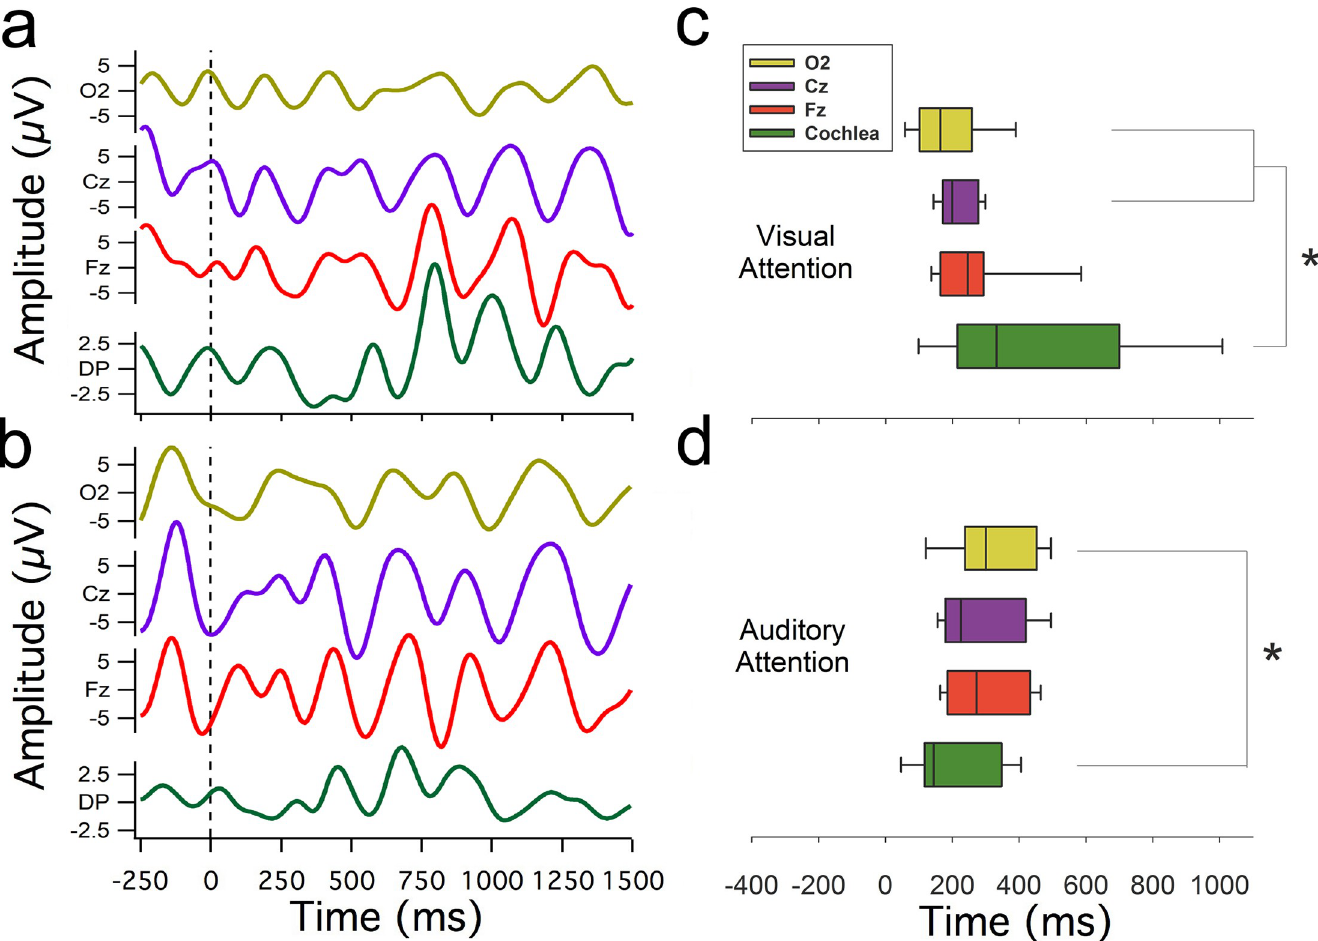
Fig 5. Temporal dynamics of brain and cochlear oscillatory activity. Examples of single trial EEG and DPOAE oscillations filtered between 1 and 7 Hz are shown in (a) visual attention and (b) auditory attention. Box plots in (c) and (d) represent, for the visual and auditory case respectively, the group distribution of the half times of the oscillatory peak activity in the 1–7 Hz frequency band of EEG recordings from O2 (yellow), Cz (purple), Fz (red) and cochlea (green, DPOAE signal). Asterisks denote a statistically significant difference of half-peak times (p < 0.05, Mann-Whitney tests) between DPOAE amplitude and O2 for both modalities, and also with Cz in the visual attention case. Notice the wider distribution of half times in DPOAE oscillations (green boxes) during visual attention as compared to auditory attention.